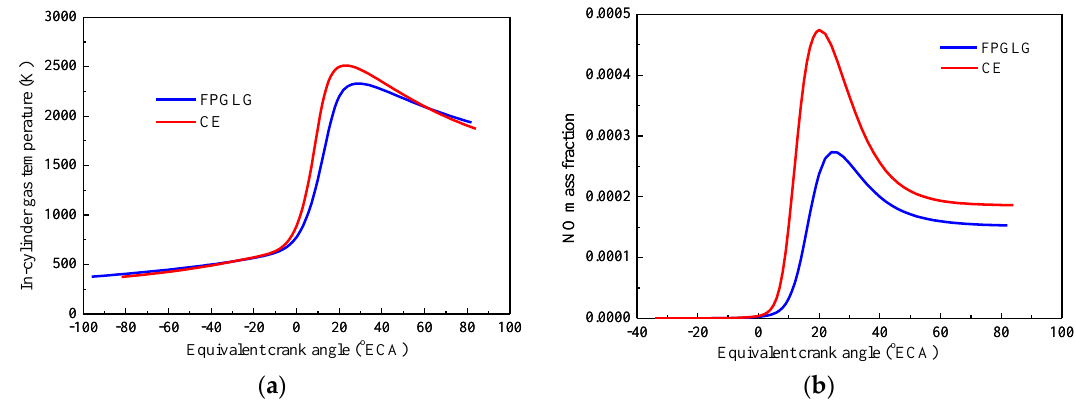
Figure 16. ( a ) Comparison of the mean in-cylinder gas temperature; ( b ) comparison of the in-cylinder NO mass fraction.